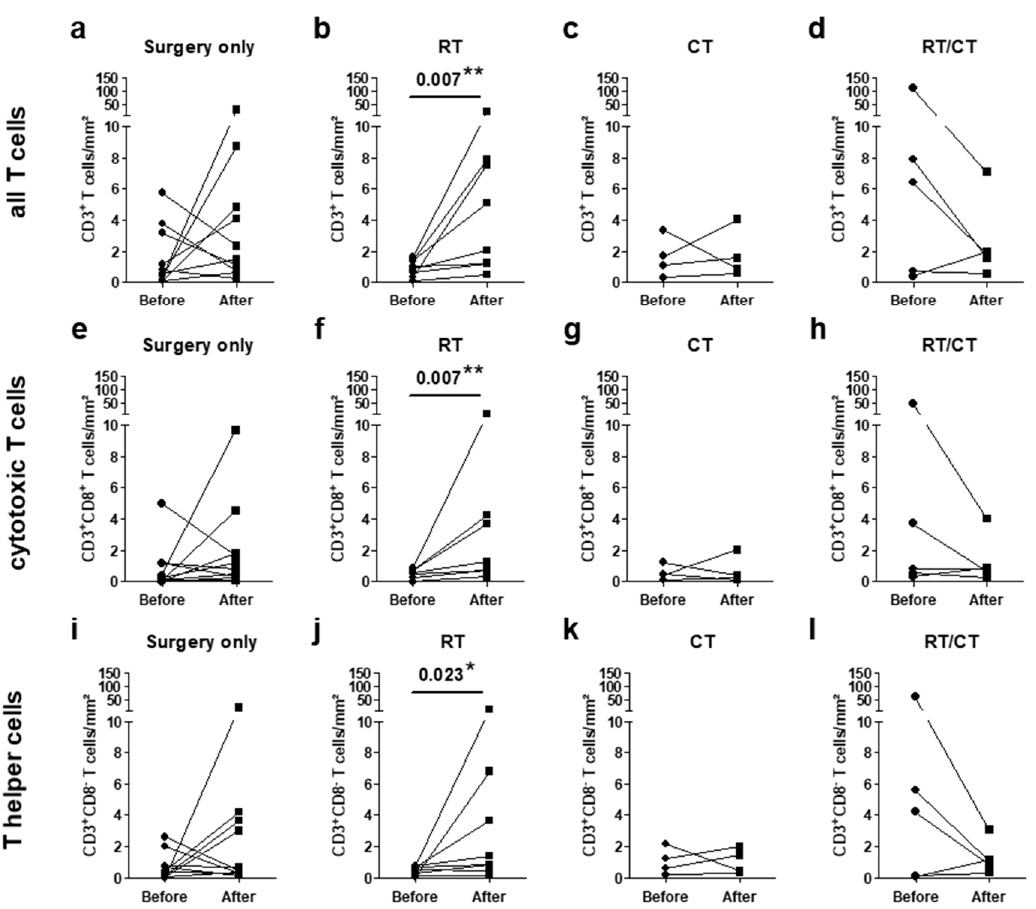
Figure 5. T-cell infiltration in pairs of IDH mut glioma before and after adjuvant treatment: infiltration of ( a – d ) all T cells, ( e – h ) cytotoxic T cells, and ( i–l ) T helper cells were analyzed in pairs of glioma